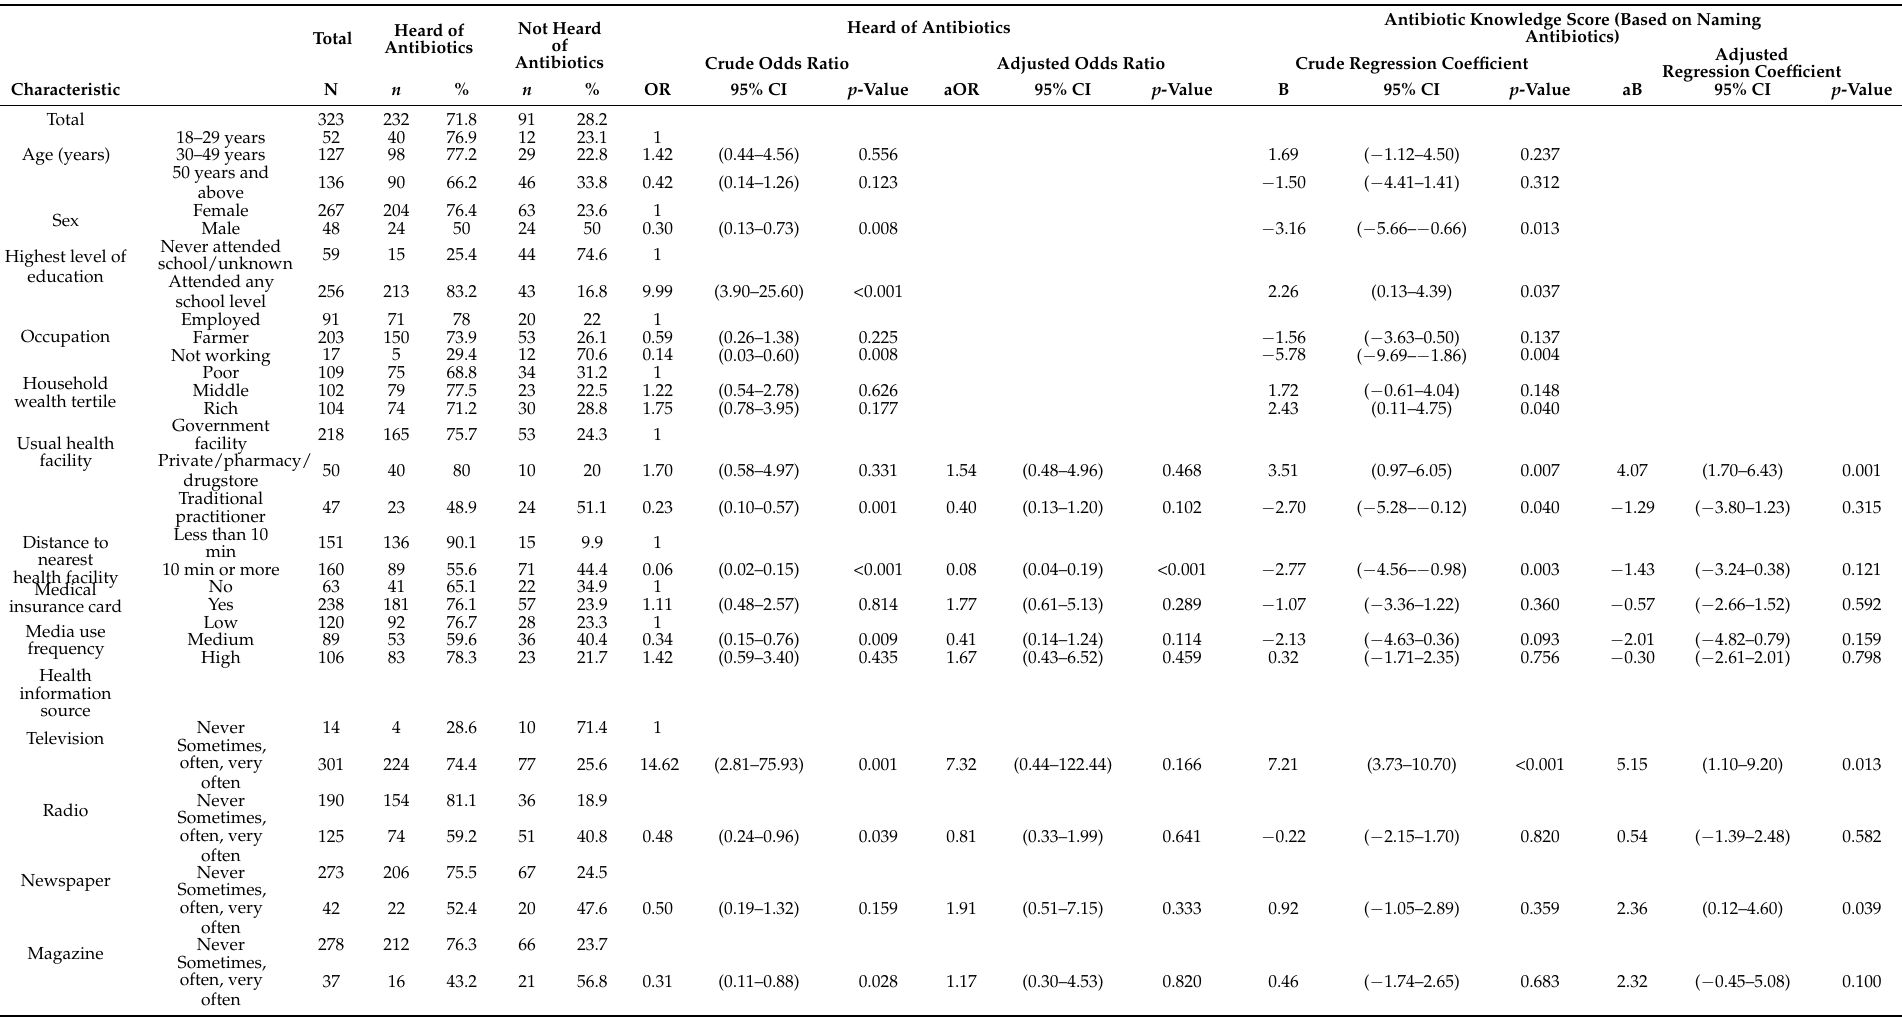
Table 2. Univariable and multivariable regression modelling of antibiotic